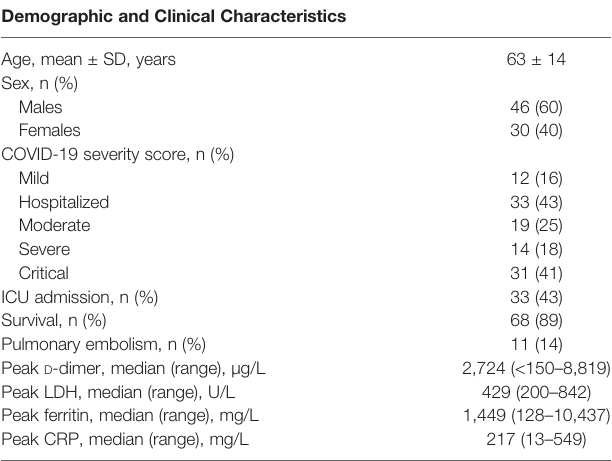
TABLE 1 | Clinical Characteristics of Included